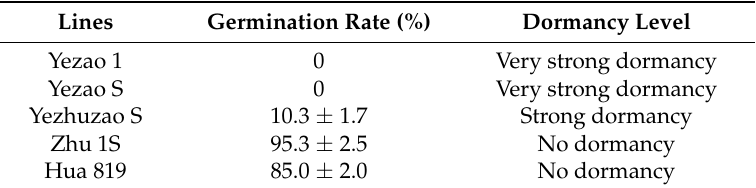
Table 3. Comparison of germination rate and seed dormancy among different rice lines.